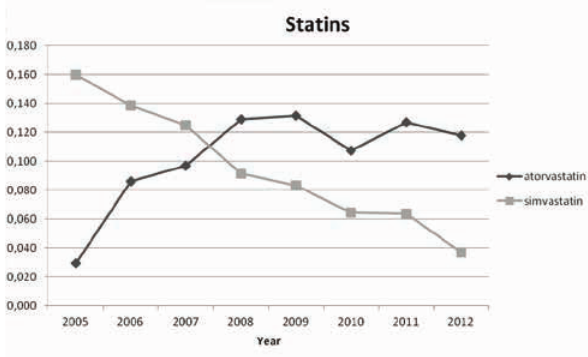
Figure 2: Antidiabetics were associated with a decrease in insulin significant at the 1% significance level, whereas an increase in met- formin use was significant at the 5% significance level.